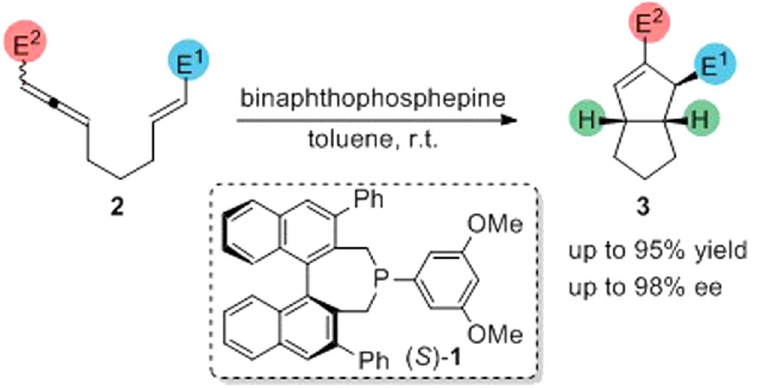
Figure 1. Binaphthophosphepine-catalyzed enantioselective intramolecular [3 + 2]